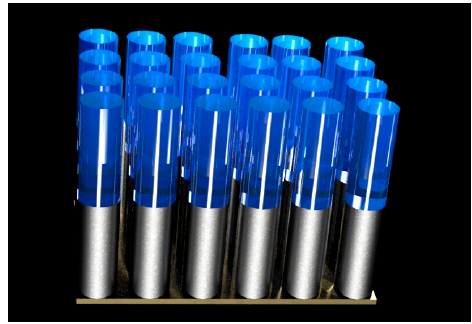
Figure 7. Schematic illustration of Au-PPy nanorods.